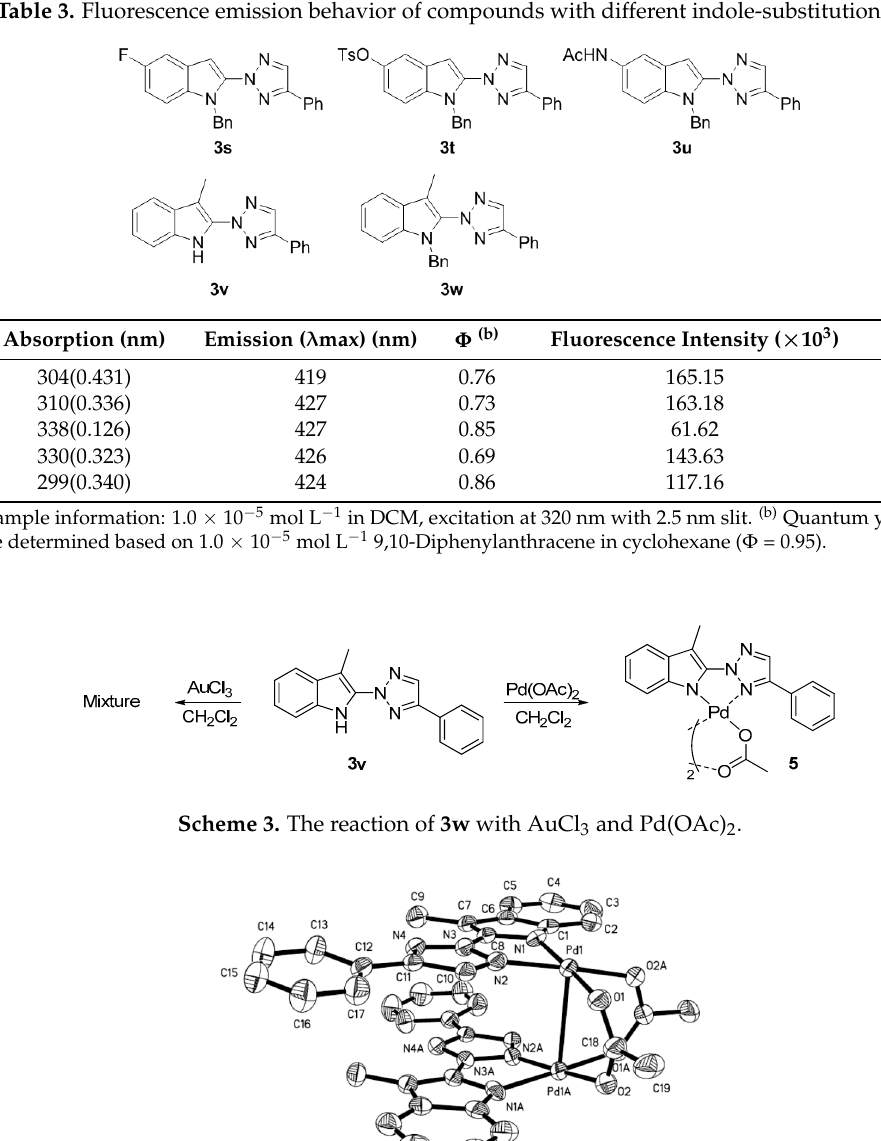
Figure 6. The absorption spectra of compounds 3 ( s – w ).